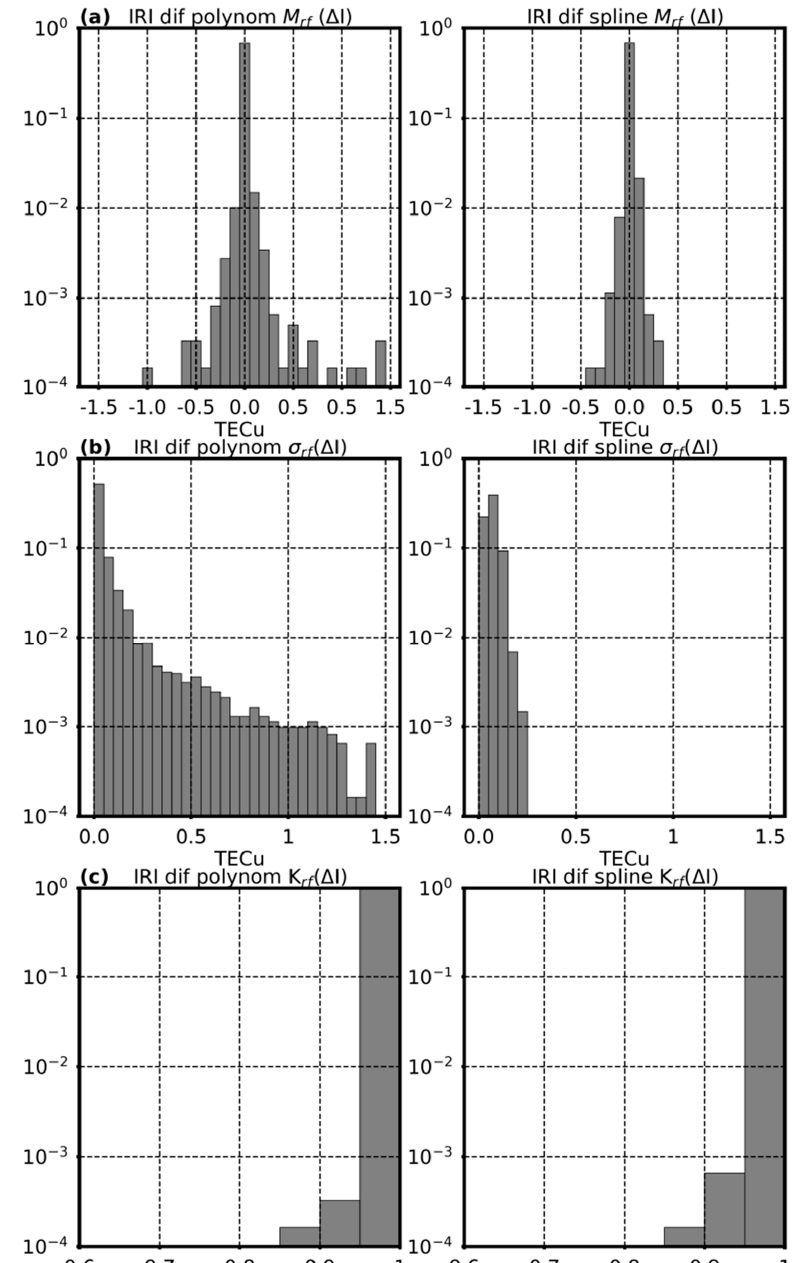
Figure 7. The distribution of trend IRI TEC error: ( a ) Mean bias error- left for polynomial, right for spline; ( b ) Root-mean-square error—left for polynomial, right for spline; ( c ) Correlation coefficient—left for polynomial, right for spline.